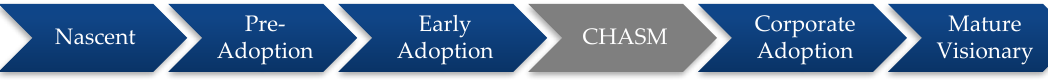
Figure 11. TDWI Analytics Stages of Maturity. Source: own elaboration based on [8].